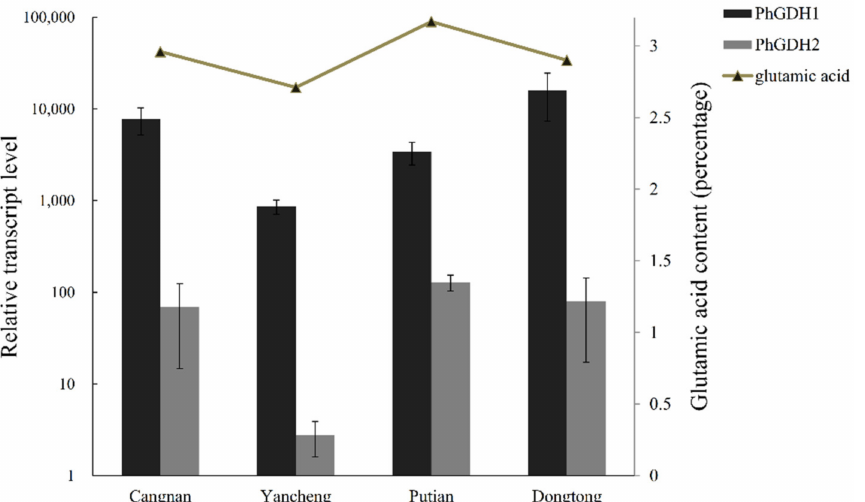
Figure 2. Transcription profiles of PhGDH 1 and PhGDH 2, as well as glutamic acid contents in P. haitanensis sampled from different cities. “percentage” means the weight ratio of amino acids to the dry weight of P. haitanensis .